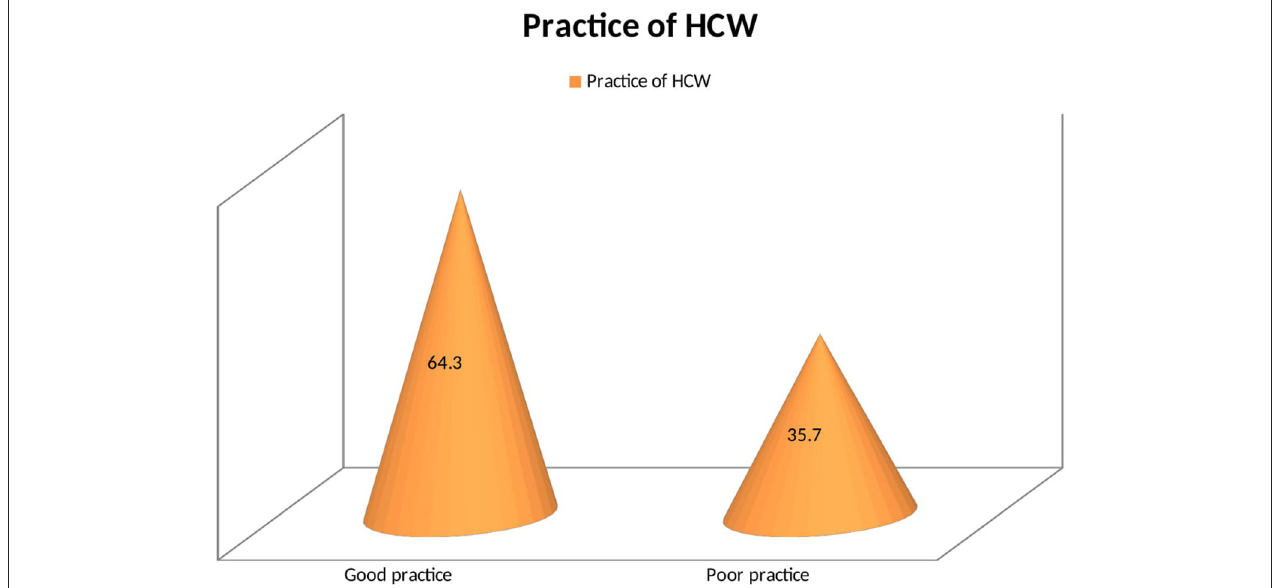
FIGURE 3 | Practice of COVID-19 prevention among health workers at Aksum University Comprehensive and Specialized Hospital (AKUCSH) and Sain’t Marry’s General Hospital in Tigray Regional State of Northern Ethiopia.